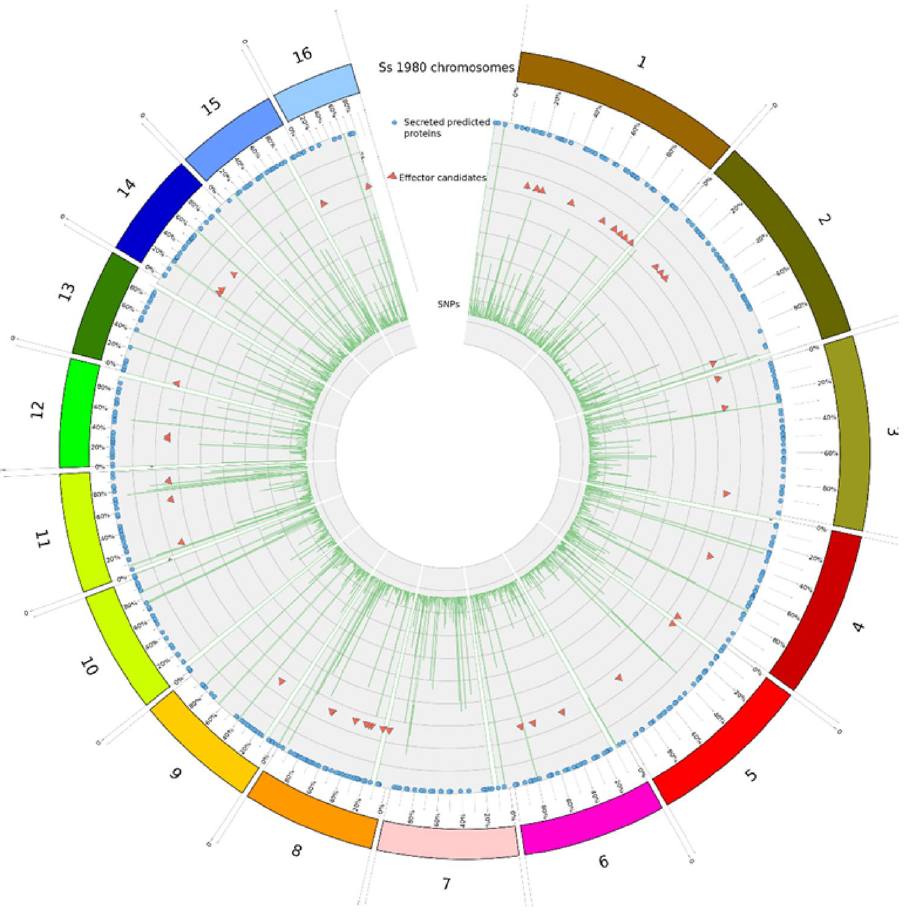
Figure 6. CIRCOS plot of the assembled scaffolds of ‘ESR-01’ against ‘1980’ isolate of S. sclerotiorum displaying comparative genomic and secretory proteins features. Schematic representation of the total SNPs, secretory proteins, and the effector proteins of the secretome data of the S. sclerotiorum ‘ ESR-01’ genome shown as a histogram (different colors and types) and inner circle (blue) is total SNPs and the scattered circle is secretory proteins and scattered red triangle is the effector proteins predicted in ESR-01 isolate. The diagram was plotted using